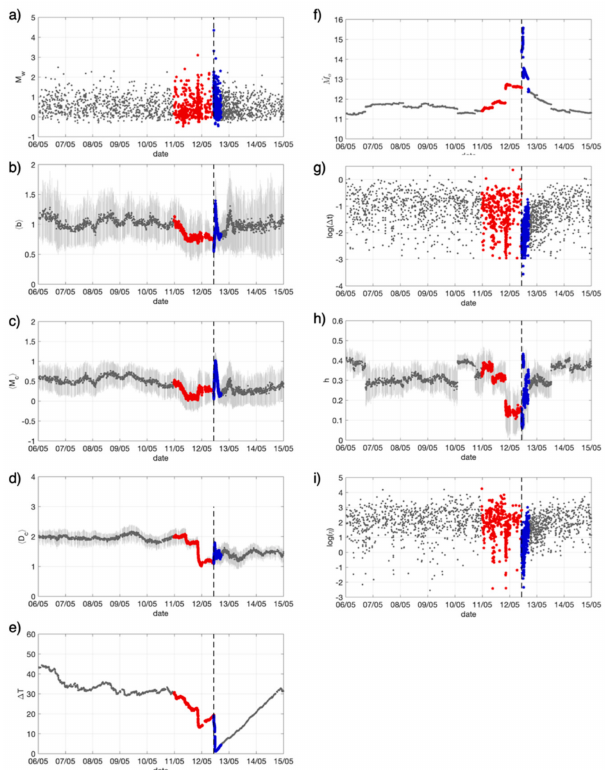
Figure 4. ( a ) Distribution of events before and after the first M4 earthquake (occurred the 12th May 2006, vertical dashed line). Background seismicity (grey dots), foreshocks (red), main-event and aftershocks (blue). All the other plots are the same as ( a ), but for: ( b ) average b-values and ± 1 SD bars (grey); ( c ) average completeness magnitude, M c , and ± 1 SD bars; ( d ) average fractal dimension, D c , and ± 1 SD bars; ( e ) total duration, ∆ T , of the events group; ( f ) Moment rate, time, ∆ t ; ( h ) Shannon entropy, h ; ( i ) Logarithm (base 10) of the generalized distance between pairs of earthquakes, η . The uncertainty associated to b-value , M c , D c and Shannon entropy h is computed by means of a bootstrap approach [73], whereas for each dataset 1000 realizations of random sampling with replacement were